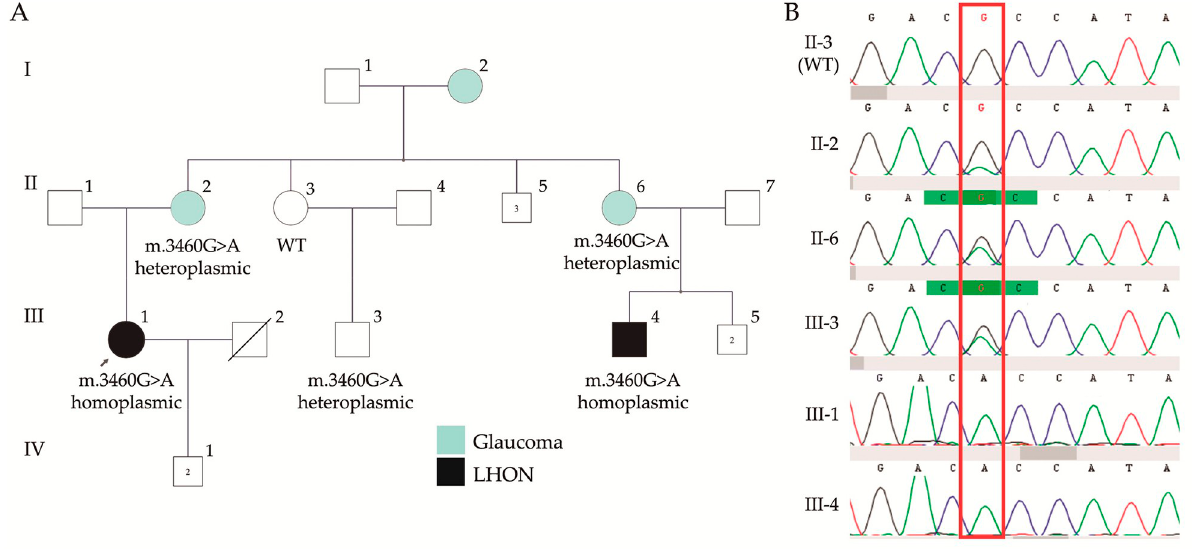
Fig 2. Family with variant m.3460G > A p.Ala52Thr in the MT-ND 1 gene. A, The variant was detected in both affected cousins III1 and III4. The analysis in the family revealed heteroplasmic segregation in II2, II6 and III3, unaffected for visual loss but who suffered glaucoma. The genetic variant was not detected by Sanger sequencing in the obligated carrier II3. B, Partial sequence chromatograms of ND1 gene from studied individuals of the family. Red square indicates the location of the base changes at positions 3460.